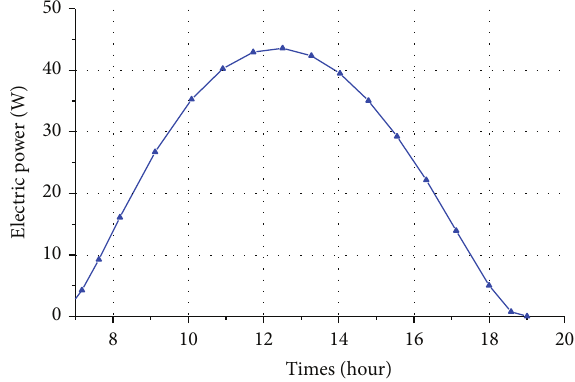
Figure 5: Electric power produced by the collector